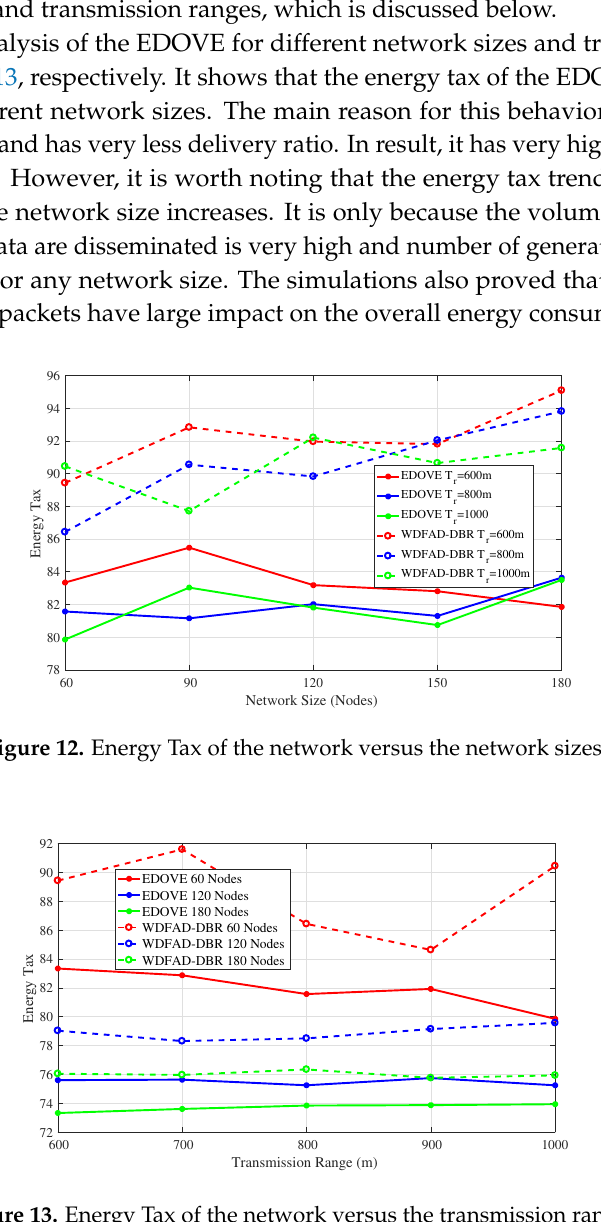
Figure 13. Energy Tax of the network versus the transmission